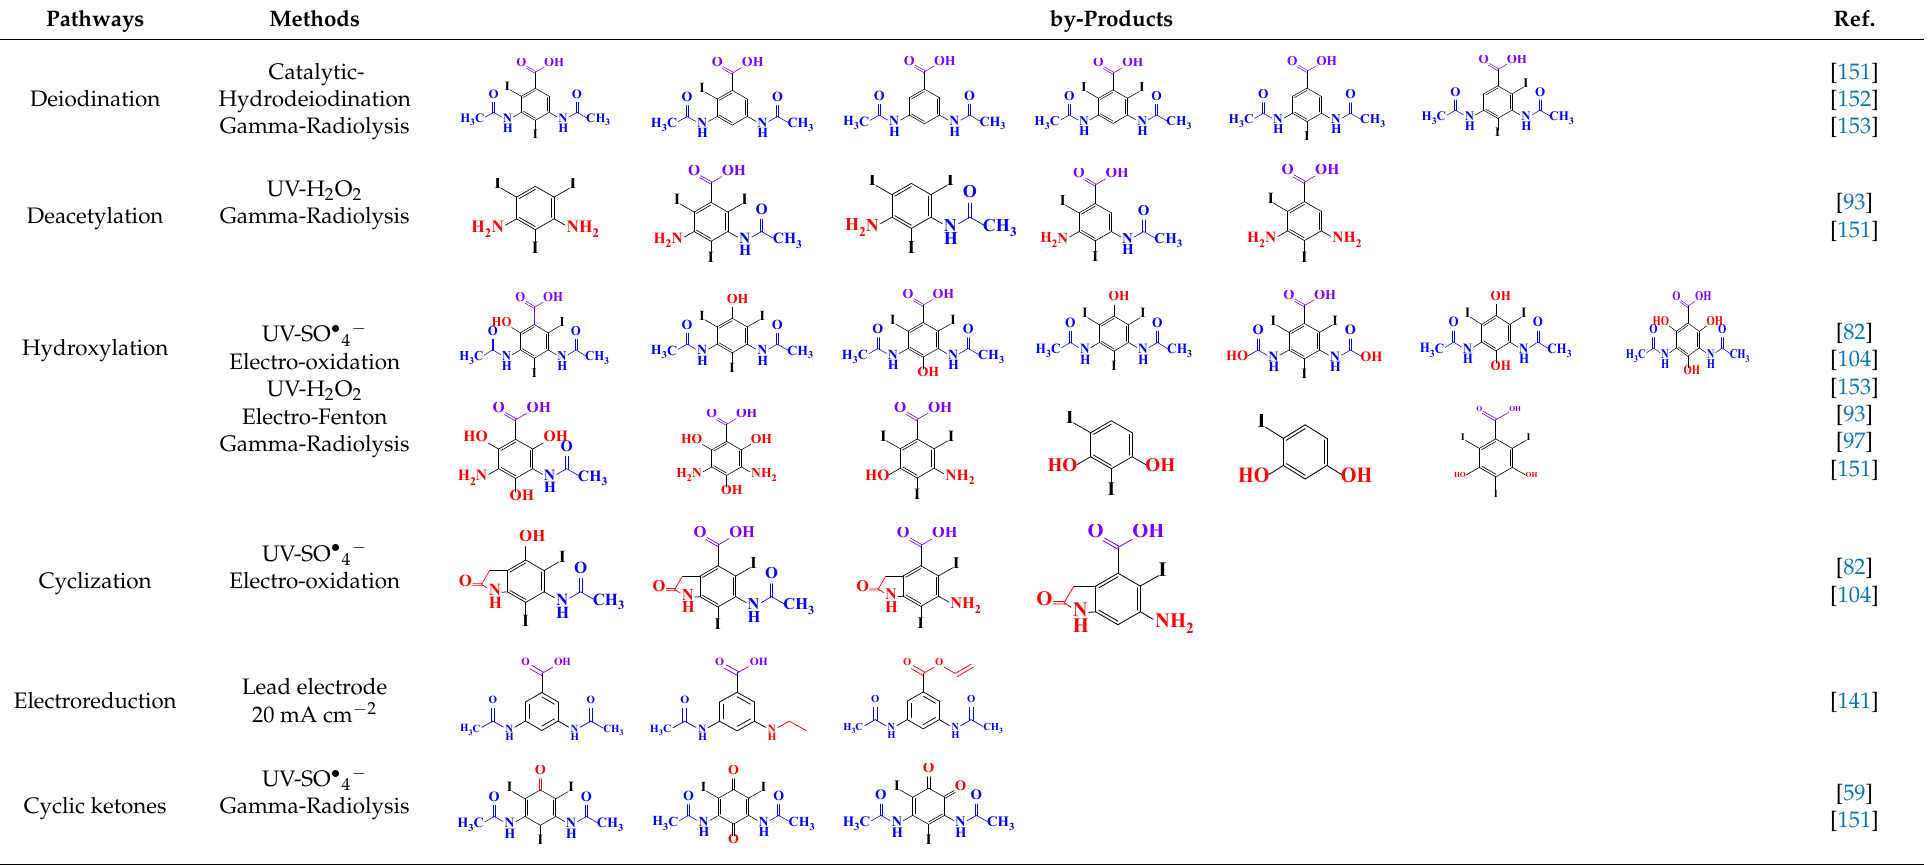
Table 6. Identified by-products of iohexol in recent literature. by-Products Ref.